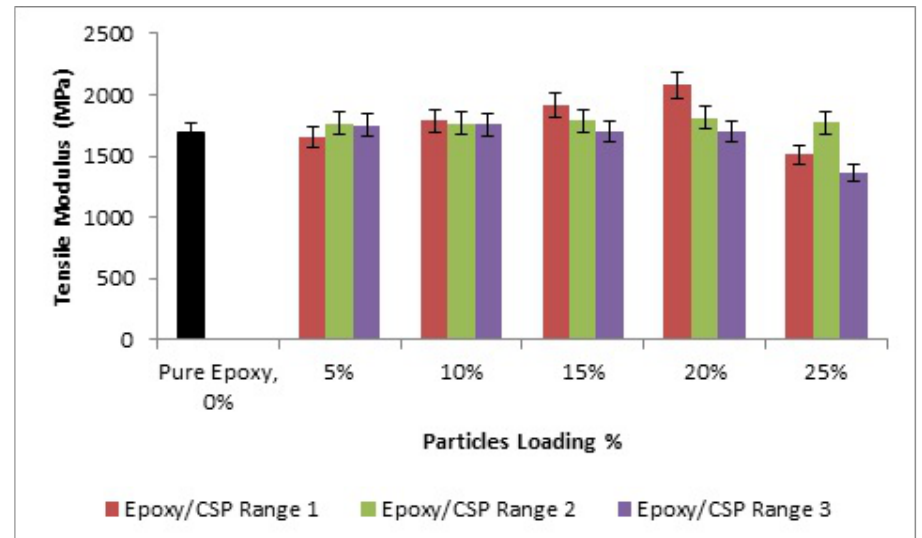
Figure 4: Tensile modulus versus various particles loading